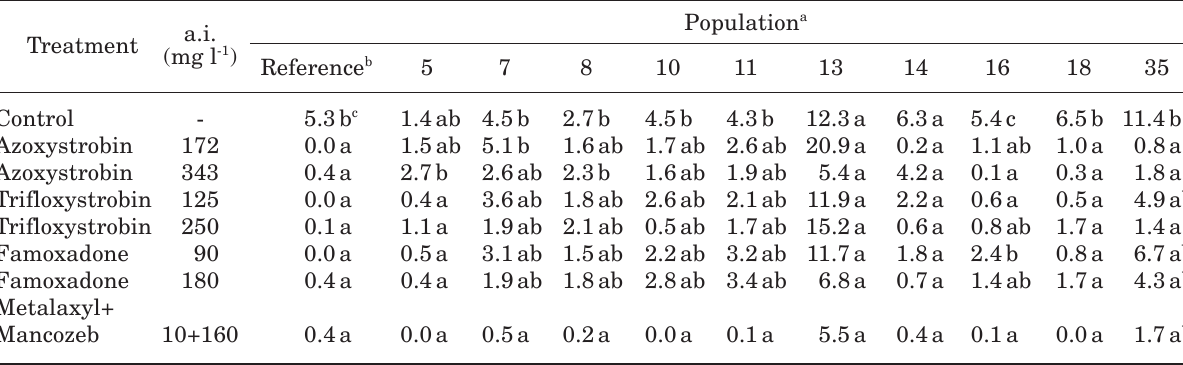
Table 6. Sensitivity to Qo1 fungicides (expressed as percent leaf area showing downy mildew symptoms 15 days after the inoculation with 1 (cid:1) 10 5 sporangia ml -1 ) of populations of P. viticola collected in 2001 from vineyards located in Trentino Alto Adige and tested on potted grape